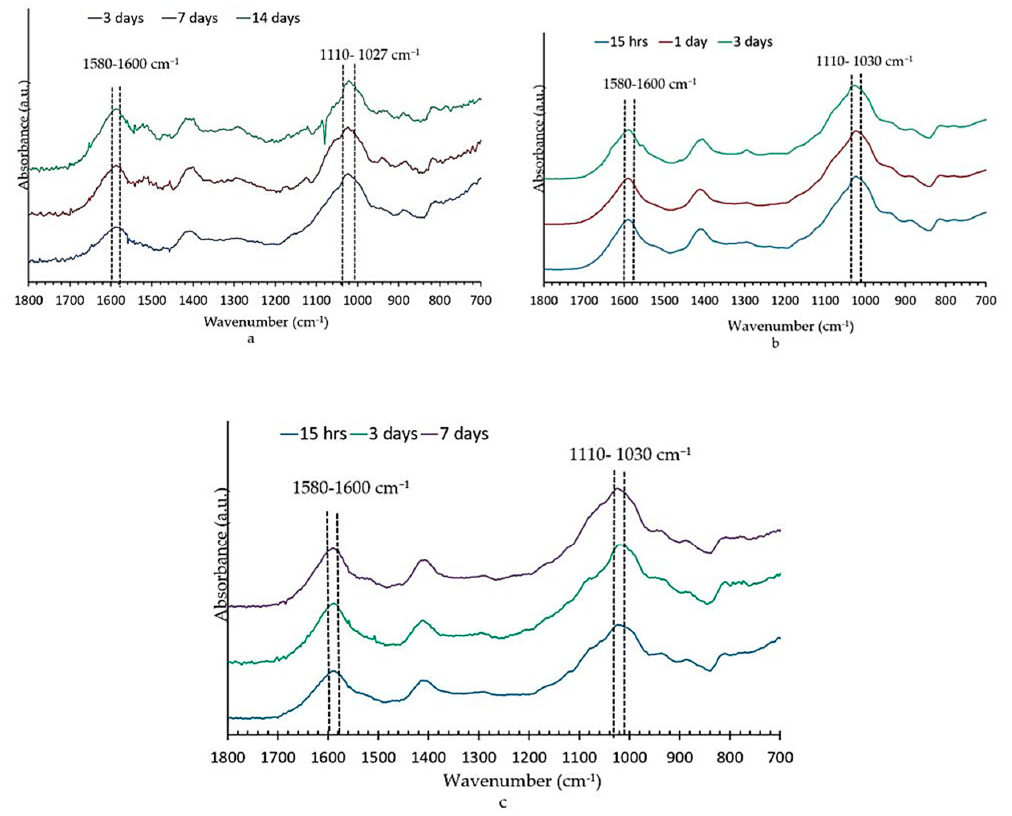
Figure 10. FTIR spectra of type 1 ( a ), type 2 ( b ), and type 3 ( c ) bone scaffolds that were cross-linked with calcium chloride ( a,b ) and strontium chloride ( c ) after immersion in the Tris/HCl buffer at different time points.